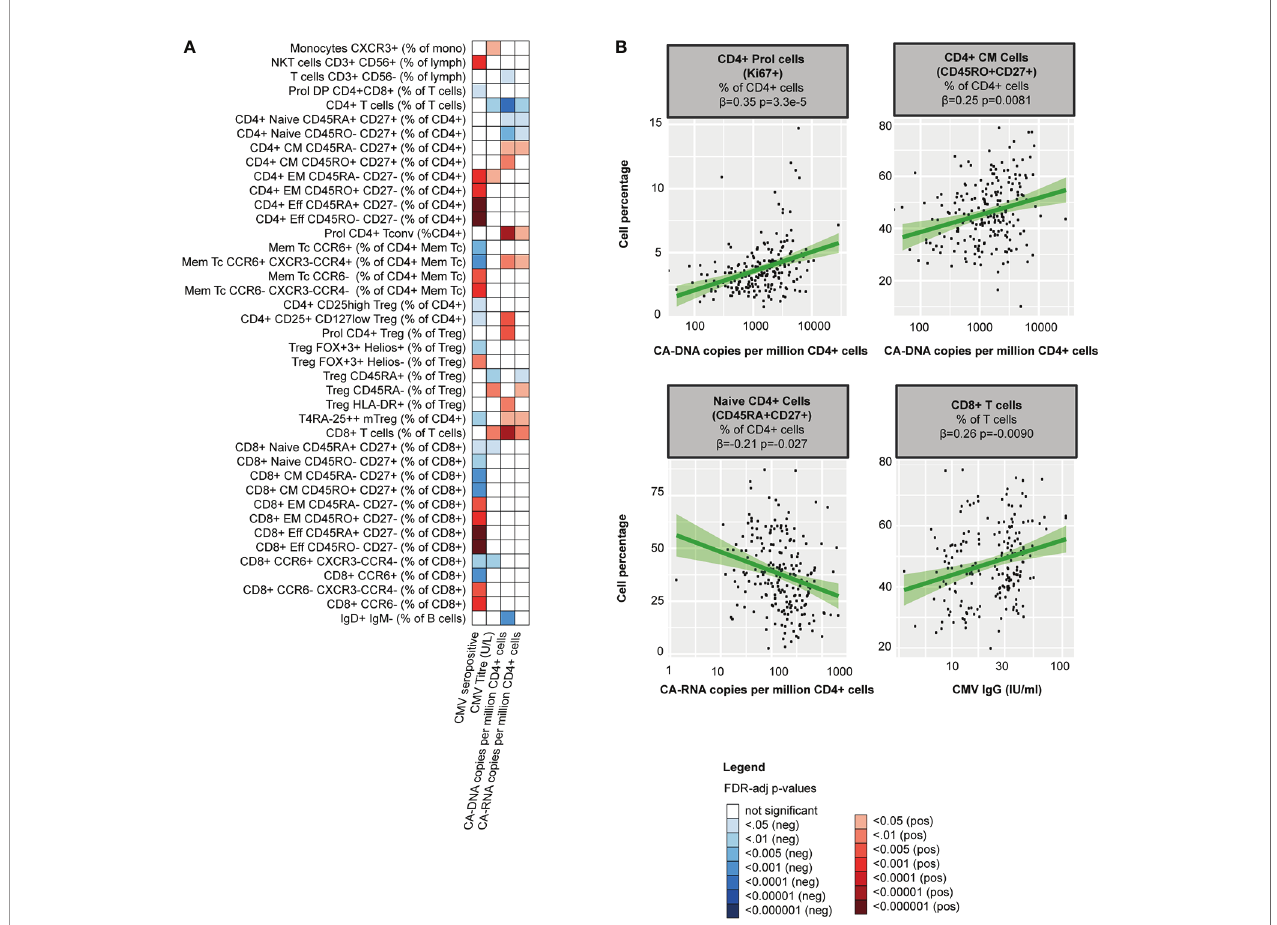
FIGURE 4 | The HIV-1 reservoir, CMV serostatus and WBC percentages in PLHIV (A) Heatmap of signi fi cant associations between WBC percentages (total n=108), CMV co-infection (serostatus and IgG titers in 198 seropositive PLHIV) and markers of the HIV-1 reservoir (CA -DNA and CA- RNA) in 211 PLHIV; WBC subsets that showed no signi fi cant correlations with any of the parameters (n=41) have been removed from the fi gure. (B) Examples of WBC percentages that were signi fi cantly associated with the viral reservoir or CMV IgG titers. Inverse-rank transformed data were analyzed using linear regression and adjusted for age, sex, sampling time, and season. For color coding of the FDR-adjusted p-values see legend. CA-DNA, CD4-cell-associated HIV-1 DNA; CA-RNA, CD4-cell-associated HIV-1 RNA; CMV, cytomegalovirus; PLHIV, people living with HIV; WBC, white blood